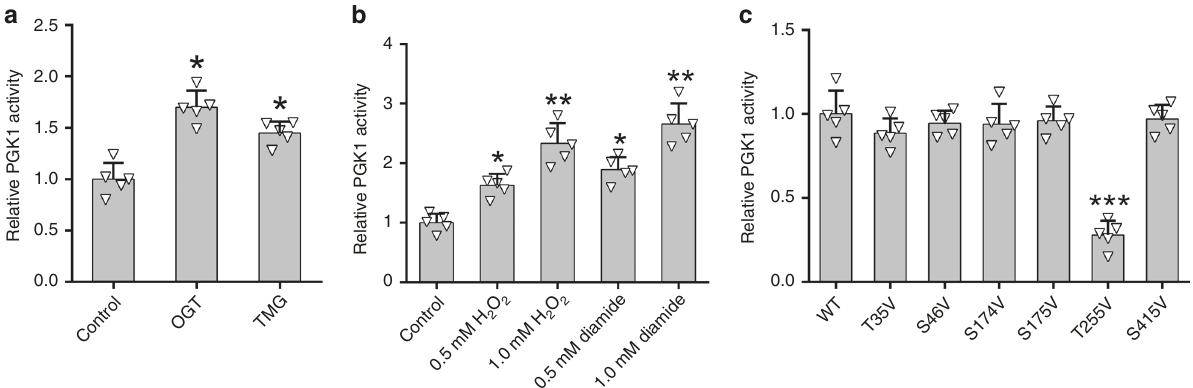
Fig. 3 T255 O-GlcNAcylation activates PGK1 enzyme activity. a Enzymatic activity of PGK1 under basal conditions, upon OGT overexpression or with TMG treatment. b Enzymatic activity of PGK1 upon cellular treatment with different concentrations of H 2 O 2 or diamide. c Comparison of enzymatic activity of PGK1 WT and different mutants upon OGT overexpression. Error bars denote the means± standard deviations (SD). Statistical analyses were performed by one-way analysis of variance (ANOVA) followed by Tukey ’ s post hoc test (* P < 0.05, ** P < 0.01, *** P < 0.001). Source data are provided as a